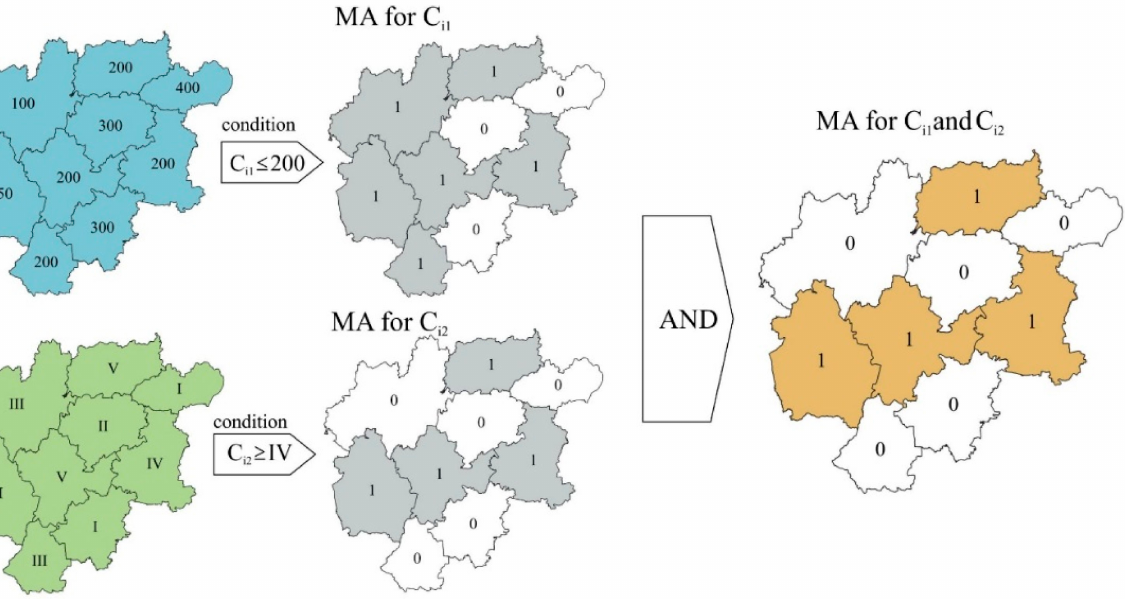
Figure 1. The process of criteria (C i1 and C i2 ) analysis and acceptable alternative development. Key: M1—map of criterion No 1 (C i1 ); M2—map of criterion No 2 (C i2 ); A—alternative; MA—map